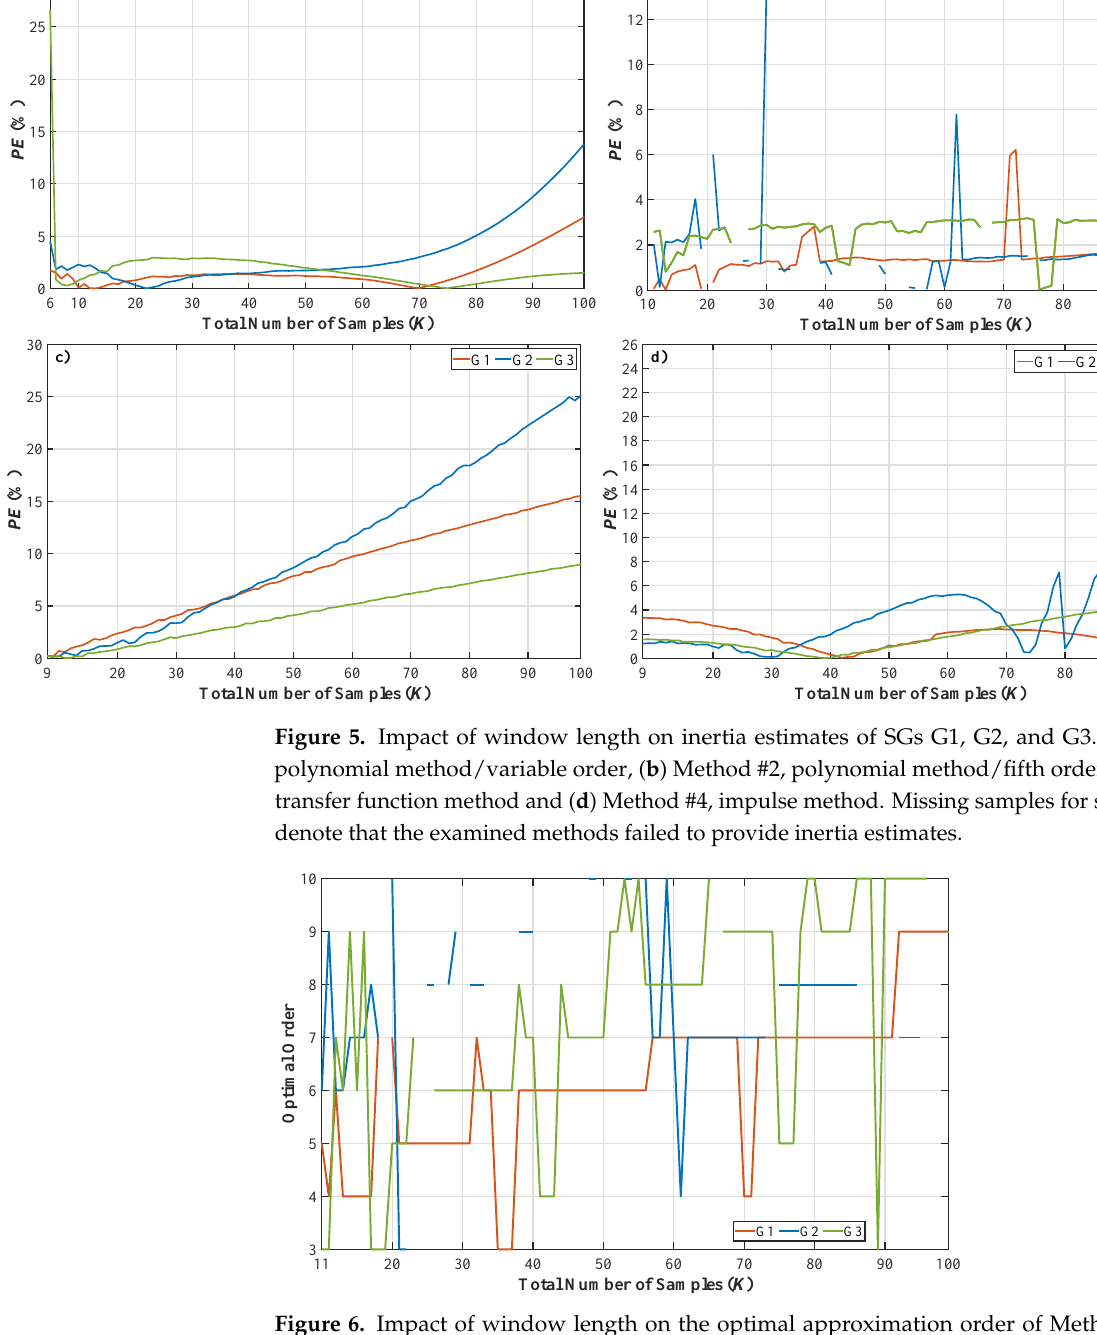
Figure 6. Impact of window length on the optimal approximation order of Method #2. Missing samples denote that the method failed to converge and to provide inertia